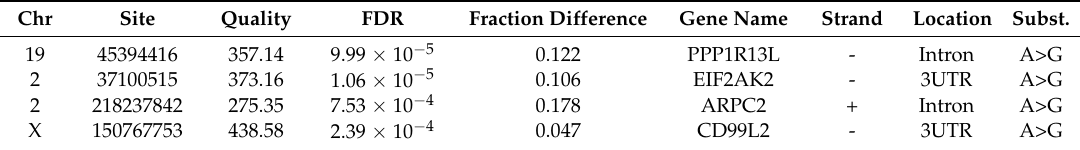
Table 6. Four main RNA editing candidates identified in IUGR-affected